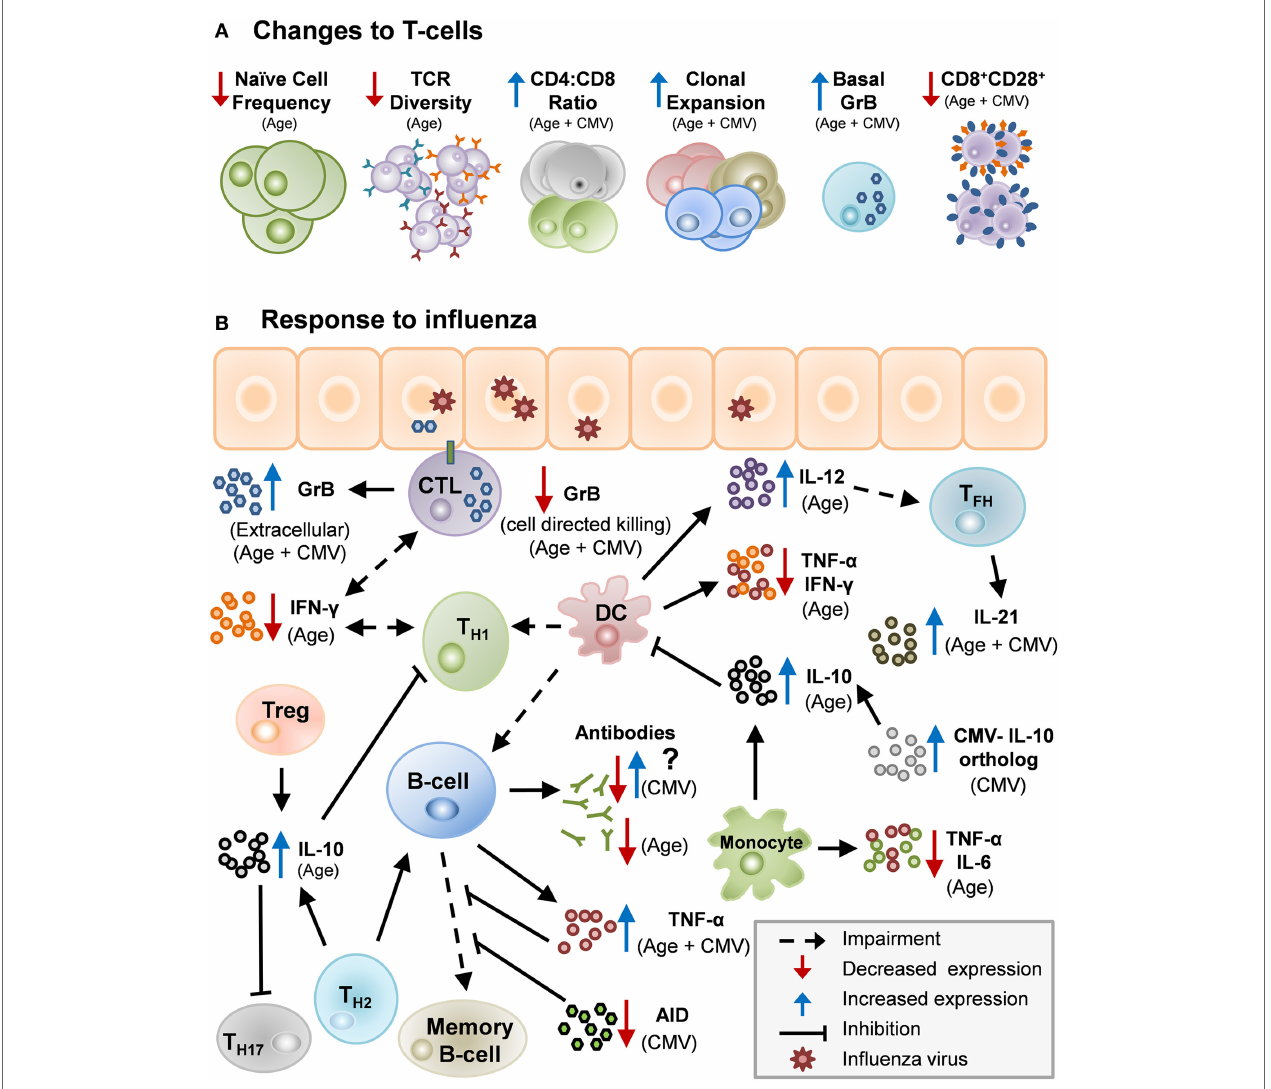
FiGURe 1 | Potential mechanisms by which age and cytomegalovirus (CMV) may cause changes in human immunity. (A) Age and CMV can act in unison to impair aspects of the immune system: lower numbers of naïve T-cells, decrease in T-cell receptor (TCR) repertoire, heightened CD4:CD8 ratio, clonal expansion, increased levels of basal granzyme B (GrB) in resting T-cells and decrease in CD8 + CD28 + cells. (B) There are several potential mechanisms by which age and CMV may cause changes in human immunity. Influenza infection stimulates Th1/Th2 although impaired in older adults due to diminished antigen-presenting cell function in the elderly. Th1 response with IFN- γ activating memory cytotoxic T-lymphocyte (CTL) which clears virus from the lungs. Age-related changes drive a Th2/regulatory T-cell (Treg) response to infection, and IL-10 production suppresses the CTL response. CMV infection further impairs the response to influenza infection by contributing to age-related impairments and by other